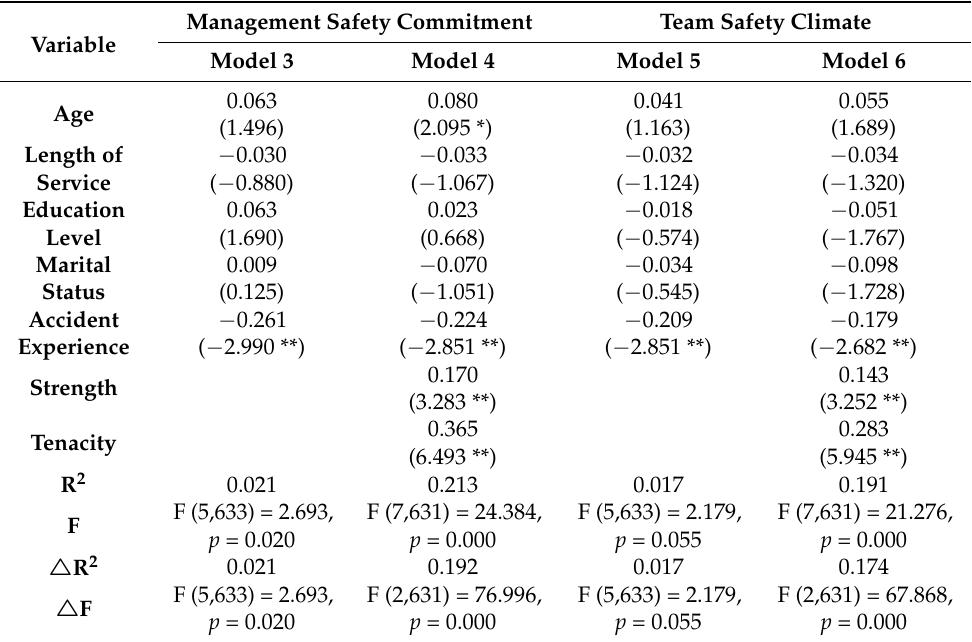
Table 12. Regression analysis of two dimensions of resilience on management safety commitment and team safety climate (N =